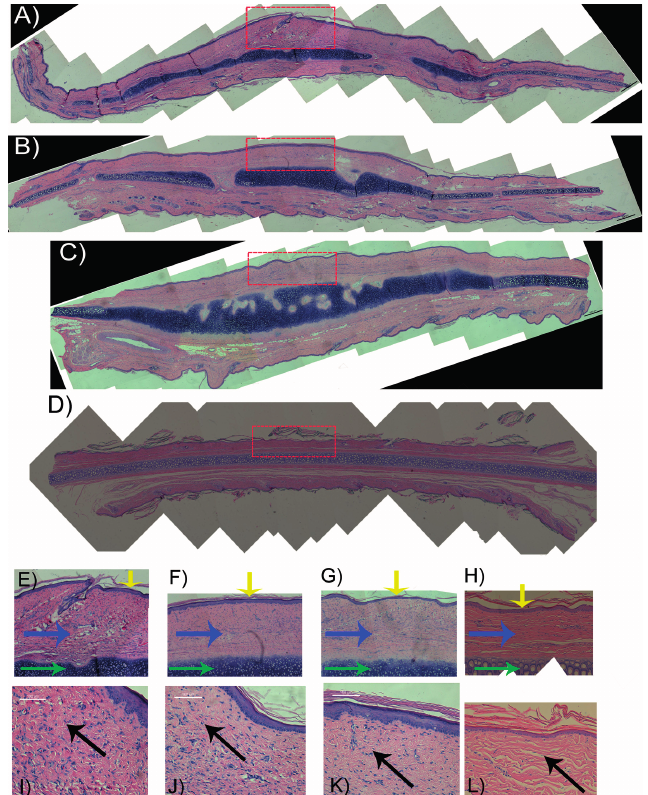
application of different treatments for 30 days. ( A , E , I ): Control group; ( B , F , J ): 5-FU EGs group; ( C , G , K ): 5-FU Gels group; ( D , H , L ): Normal skin; ( A – D ) over-view of H&E images in different groups. Representative images labeled by red dot lines are shown in details in ( E – H ), respectively. Dermal thickness was significantly higher in control group scars ( E ) than in 5-FU Gels group ( G ) and 5-FU EGs group ( F ). Representative histological ( I – L ) observations were made in the hypertrophic scar tissue. (Original magnification, 2× for ( A – D ); 20× for ( E – H ), 200× for ( I – L )). The yellow arrow labeled epidermis; the blue arrow showed dermis (scar tissues); the green was cartilage tissue and the black arrow showed collagen